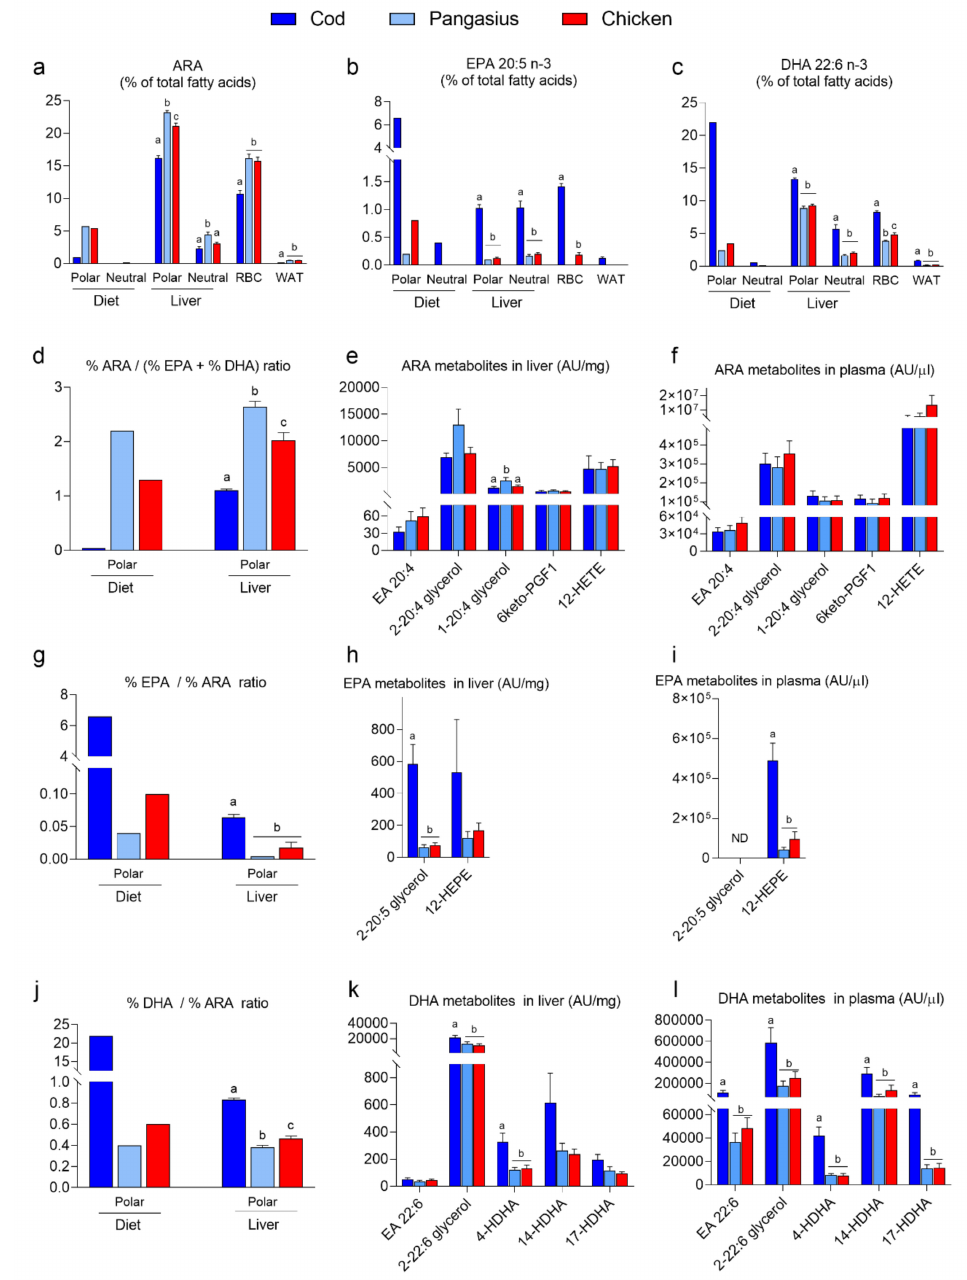
Figure 5. Relative proportion of ( a ) arachidonic acid (ARA), ( b ) eicosapentaenoic acid (EPA) and ( c ) docosahexaenoic acid (DHA) in neutral and polar fractions of HF / HP diets, neutral and polar fractions of mice livers ( n = 10), red blood cells (RBCs) and white adipose tissue (WAT). ( d ) Relative ARA:(EPA + DHA) ratio in polar lipid fractions of diets and livers. ( e , f ) ARA-derived lipid mediators; anandamide (EA 20:4), 2-arachidonoyl glycerol (2-20:4 glycerol), 1-arachidonoyl glycerol (1-20:4 glycerol), 6-keto PGF 1 , and 12-HETE in livers ( e ) and plasma ( f ). ( g ) Relative EPA:ARA ratio in polar lipid fractions of diets and livers. ( h , i ) EPA-derived lipid mediators; 2-eicosapentanoyl-glycerol (2-20:5 glycerol) and 12-HETE in livers ( h ) and plasma ( i ). ( j ) Relative DHA:ARA ratio in polar lipid fractions of diets and livers. ( k , l ) DHA-derived lipid mediators; docosahexaenoyl ethanolamide (EA 22:6), docosahexanoyl-glycerol (2-22:6 glycerol), 4-HDHA, 14-HDHA, 17-HDHA, in livers ( k ) and plasma ( l ). Data from livers, RBCs, WAT, and plasma are presented as the mean ± SEM and analyzed using one-way ANOVA followed by Fisher’s LSD post hoc test. Di ff erent letters denote statistical significance ( p < 0.05) between the